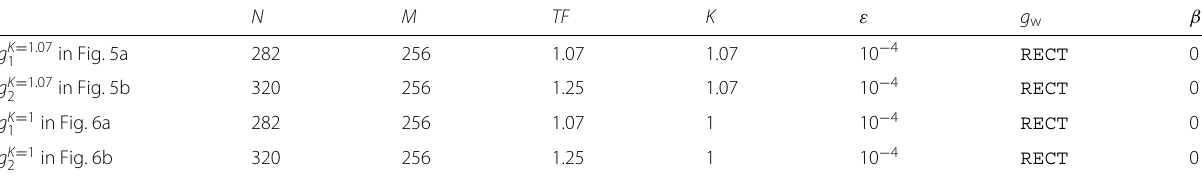
Table 3 Parameter settings for deriving short pulses with K = 1, 1.07